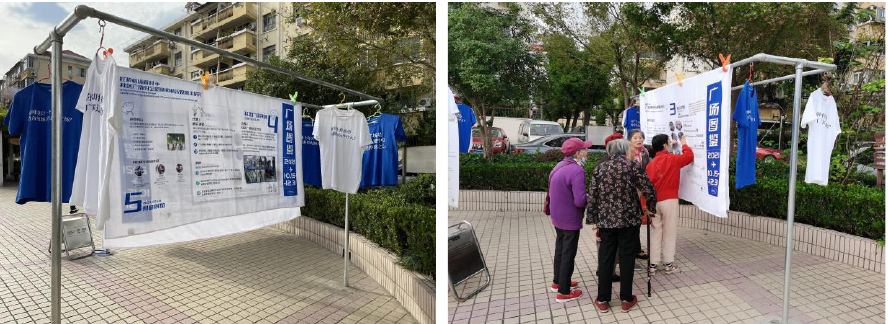
Figure 6. Community illustration exhibition. The Community Illustrated exhibition focuses on the real and diverse needs of residents in public spaces and the team's specific research. Promoting good neighborly relations between groups through information